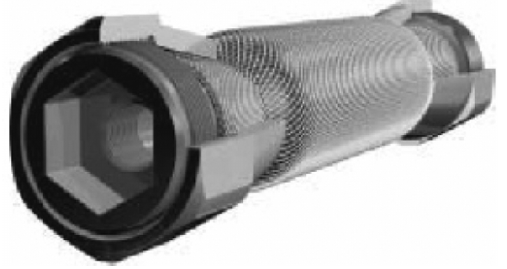
Fig. 1. Design of the Fluidic Muscle DMSP by Festo AG and Co.